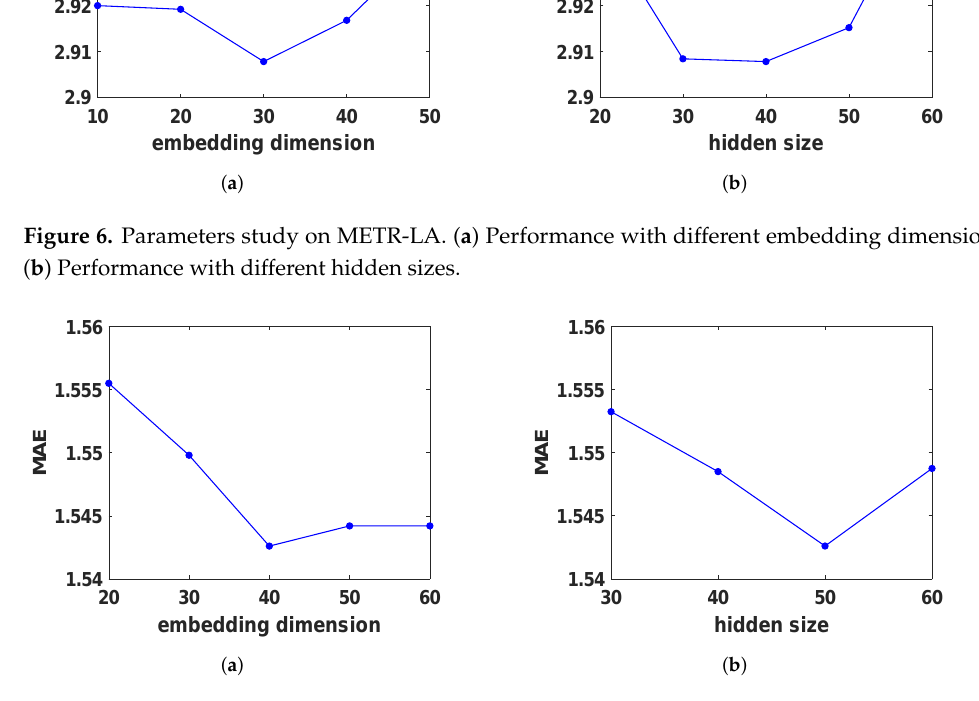
Figure 7. Parameters study on PEMS-BAY. ( a ) Performance with different embedding dimensions. ( b ) Performance with different hidden